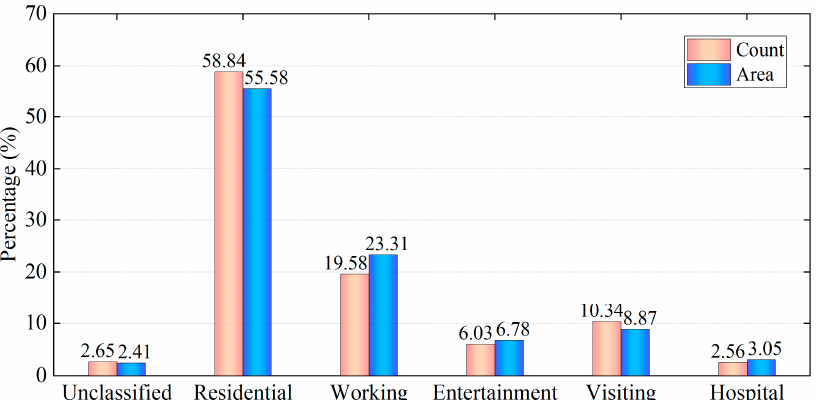
Figure 17. Statistics on the count and area of identified building types in the study area.